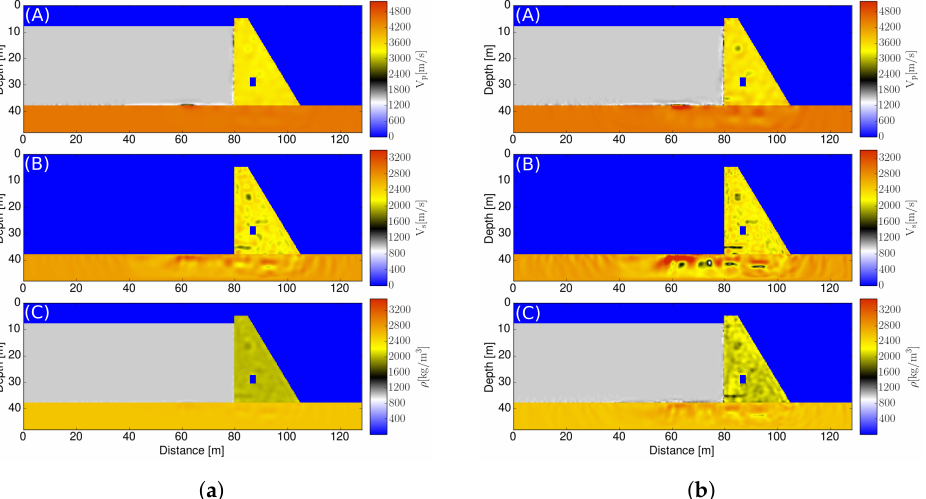
Figure 15. FWI results at iteration stages 6 and 28 considering a noise level of 2%. ( b ) shows better anomaly identification despite having a higher reconstruction error. ( a ) Reconstruction at 6th iteration ( b ) Reconstruction at 28th iteration (final). Table 2. FWI computational time after 13 iterations and number of iterations per frequency stage number both for consideration of noise in